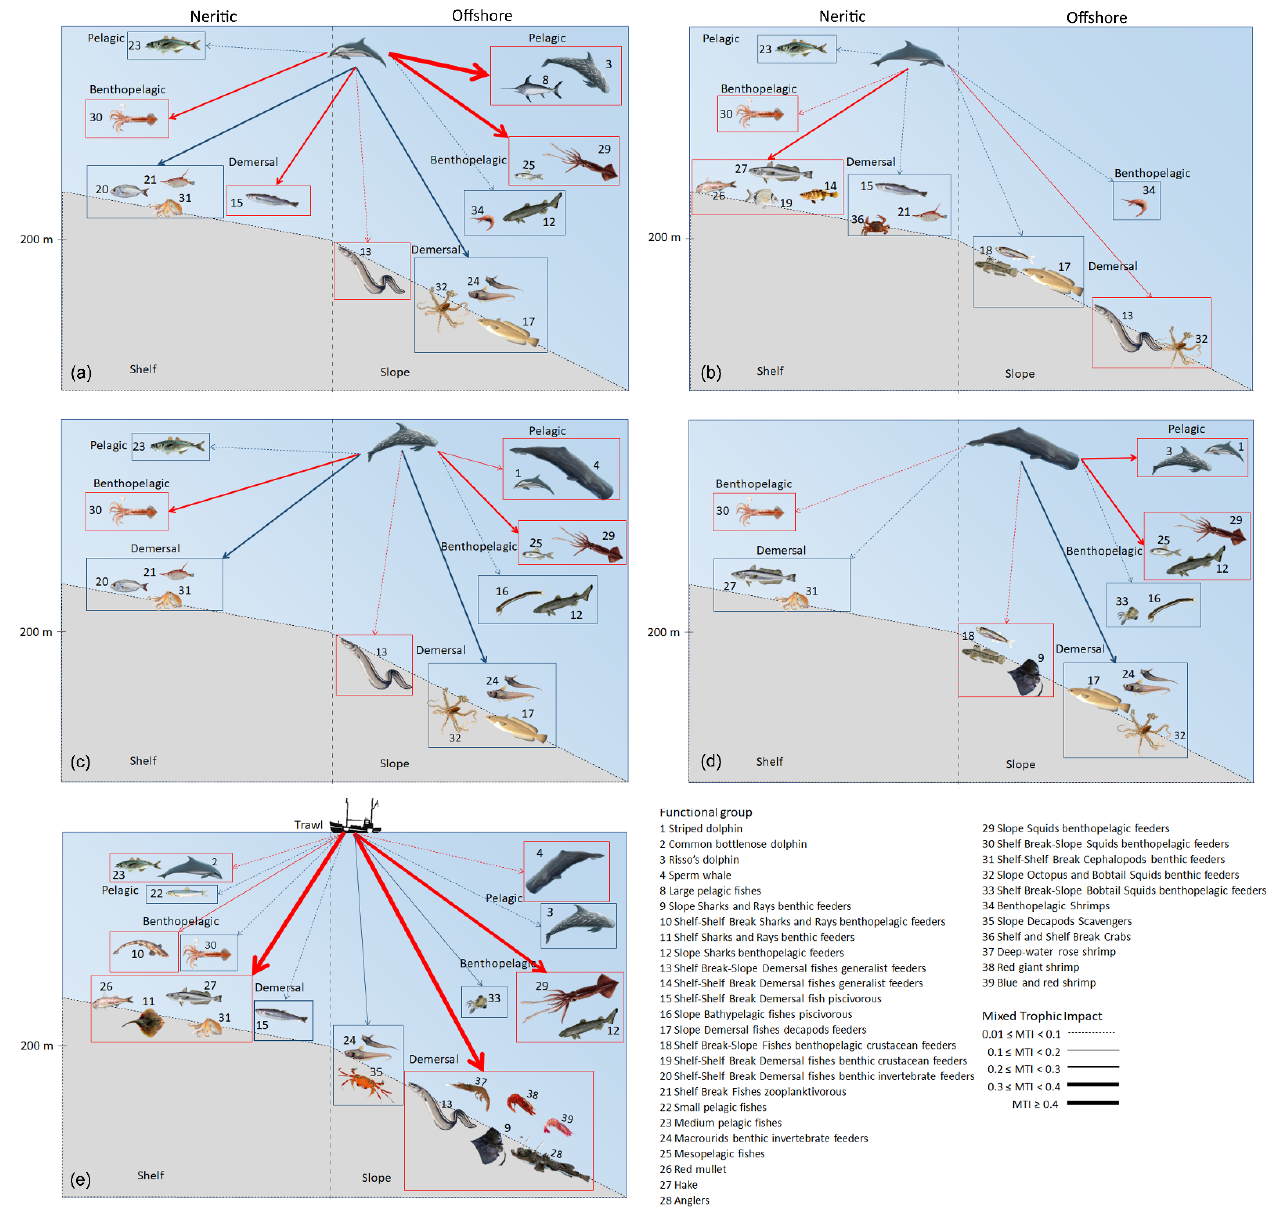
Figure 4. Positive (blue) and negative (red) trophic impacts made by ( a ) the striped dolphin, ( b ) common bottlenose dolphin, ( c ) Risso’s dolphin, ( d ) the sperm whale and ( e ) the trawl on the functional groups aggregated into pelagic, benthopelagic, and demersal domains within the food web of the Gulf of Taranto. The bathymetric separation between shelf and slope as well as neritic and offshore areas are indicated by the mark of 200 m of depth and the dashed line. FG code numbers are reported in the legend.